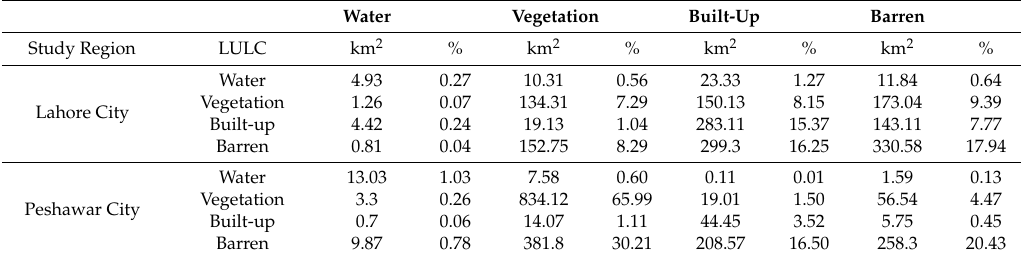
Table 4. LULC class changes from 1998 to 2018 for Lahore city (top) and Peshawar city (bottom). The table shows the change of the LULC in the left column to the LULC in the top row in both km 2 and %. For instance, in Lahore, 150.13 km 2 of vegetation was turned into built-up area. See the text for more